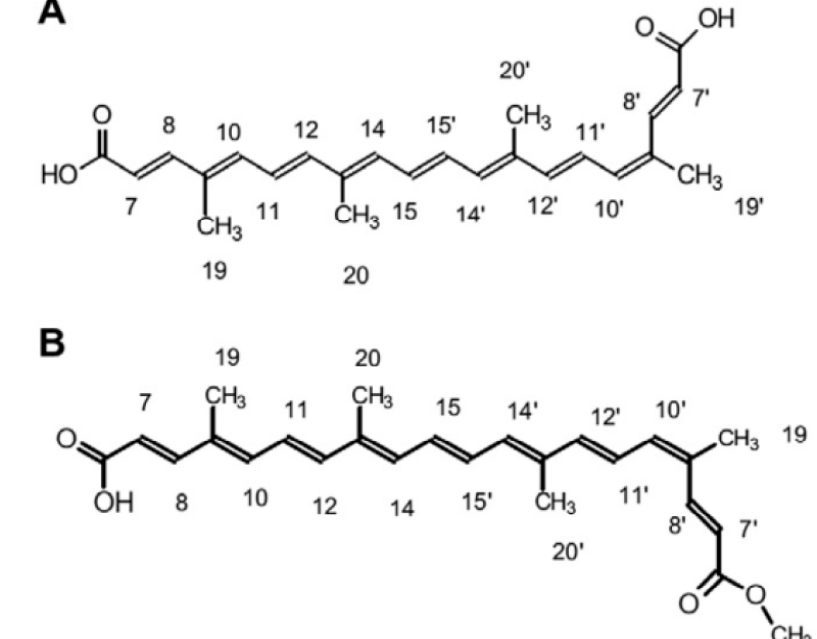
Fig. 2. Chemical structure of carotenoids present in Bixa orellana L.: a)cis-norbixin and